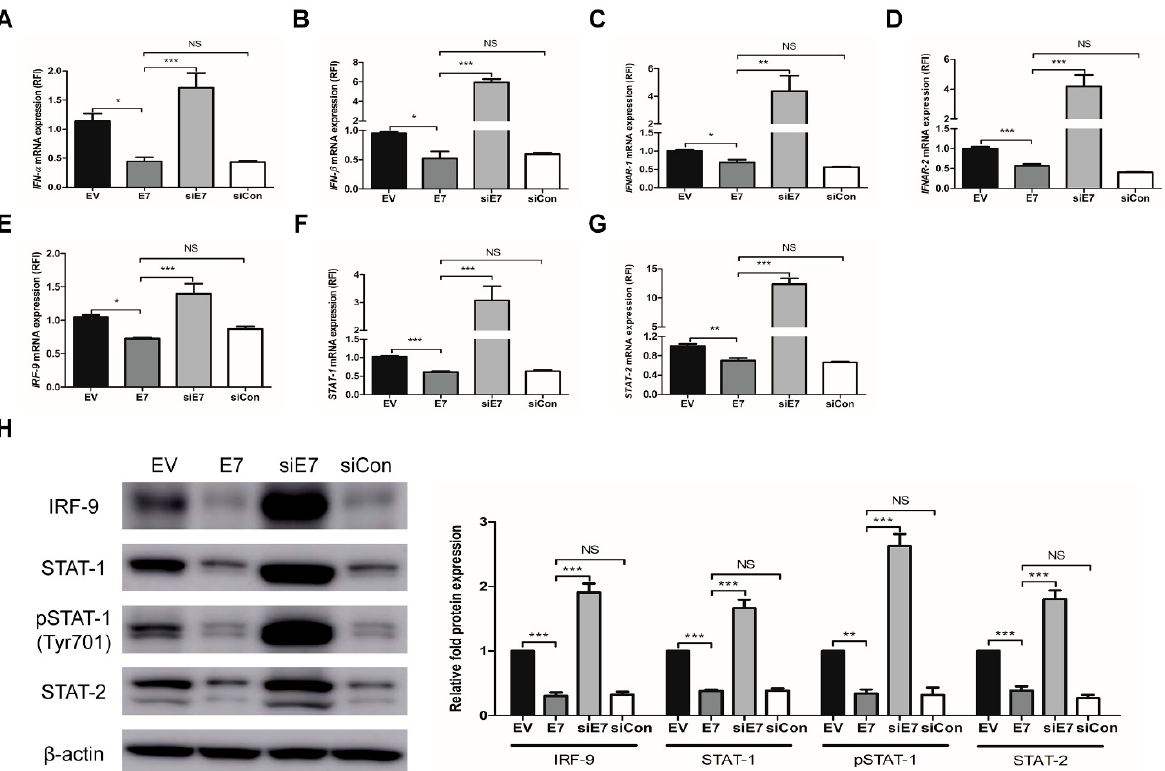
Figure 3. Effect of HPV-2 E7 transfection on the expressions of type I interferon signaling pathway components. HaCaT cells were transfected with empty vector, E7 , E7 specific siRNA, and negative control siRNA. ( A – G ) The mRNA expression levels of type I interferon (IFN) signaling pathway components, including IFN- α , - β and their receptors ( IFNAR-1 , 2 ), interferon regulatory factor-9 ( IRF-9 ), signal transducer and activator of transcription ( STAT ) -1, and STAT-2 were measured by RT-qPCR. The relative mRNA levels were normalized against levels of GAPDH . ( H ) The protein levels of IRF-9, STAT-1, STAT-2, and tyrosine phosphorylation STAT-1 were measured using western blot analysis. The histogram shows quantitative representation of the protein levels of unphosphorylated-ISGF-3 components obtained from a densitometric analysis. β -actin served as a loading control for protein normalization. The results are expressed as the mean ± SEM of three independent experiments. * p < 0.05, ** p < 0.01, *** p < 0.001 compared with empty vector or E7 . NS,